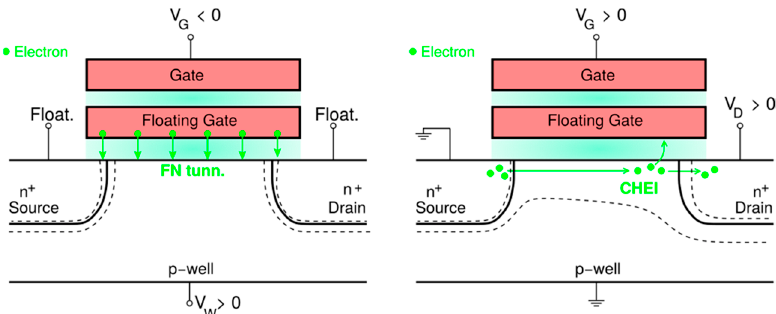
Figure 4. Physical mechanisms and corresponding voltage schemes exploited to change the amount of charge in the cell storage layer, consisting of ( left ) Fowler–Nordheim (FN) and ( right ) channel hot-electron injection (CHEI).